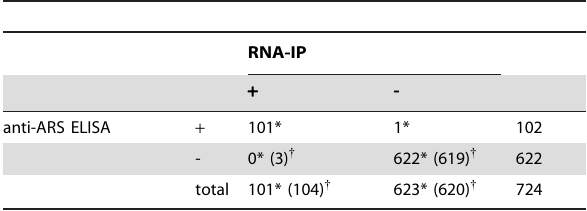
Table 1 Comparison of the results between the new ELISA system and RNA-IP.